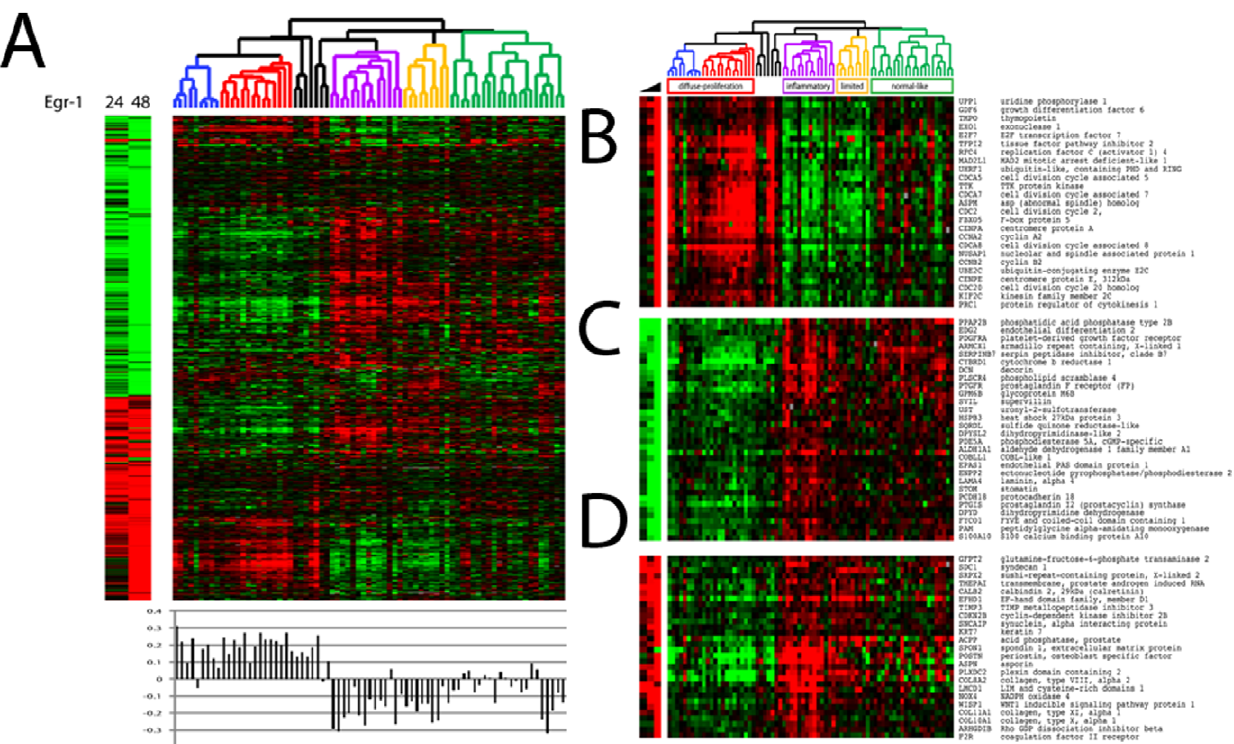
Figure 4. Expression of the Egr-1-responsive gene signature in SSc skin biopsies. A. Egr-1-responsive genes are aligned with the gene expression data from dcSSc and healthy control skin biopsies. The samples were clustered using the 647 genes that comprise Egr-1-responsive gene signature. Dendrogram shows clear differences in skin biopsies. The left branch of the dendogram (highlighted in red and blue), comprises solely dcSSc biopsies clustering with the diffuse-proliferation intrinsic subsets (diffuse 1 and diffuse 2). The right branch includes remaining dcSSc samples, as well as lcSSc, localized scleroderma and all healthy controls. Quantitation of Egr-1 signaling in each biopsy by Pearson correlation is shown below the heatmap. B. Genes showing high expression in dcSSc skin biopsies and in Egr-1-expressing fibroblasts. C. Genes associated with the inflammatory and normal-like intrinsic subsets, or low expression in proliferation subset and Egr-1-expressing fibroblasts. D. Genes showing low expression in the proliferation subset but high expression in Egr-1-expressing fibroblasts and inflammatory